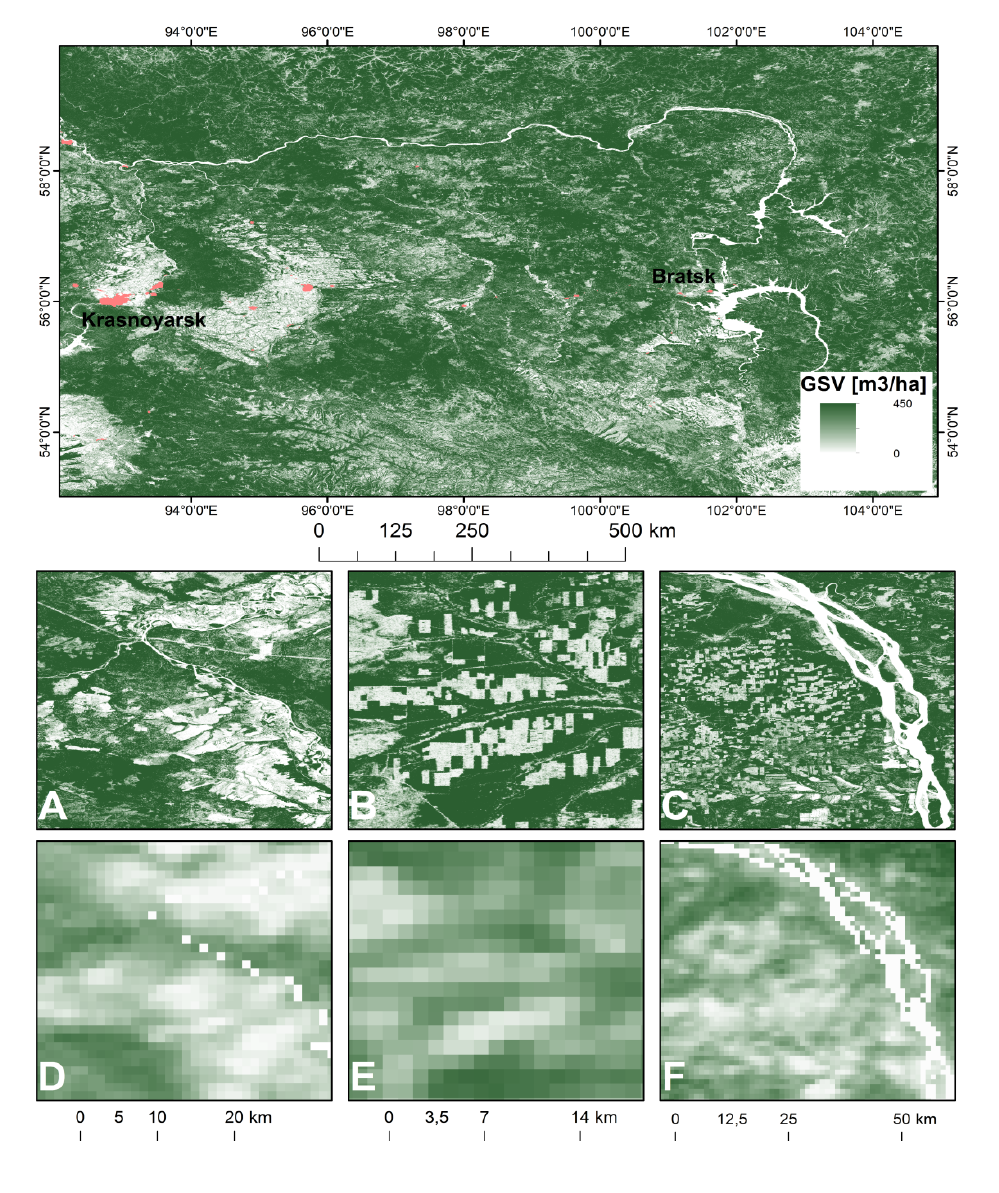
Figure 10. Mapping region of the 25 m ALOS PALSAR growing stock volume map (upper image); spatial resolution effects are shown for three examples for 25 m spatial resolution ( A – C ) and 1 km spatial resolution ( D – F